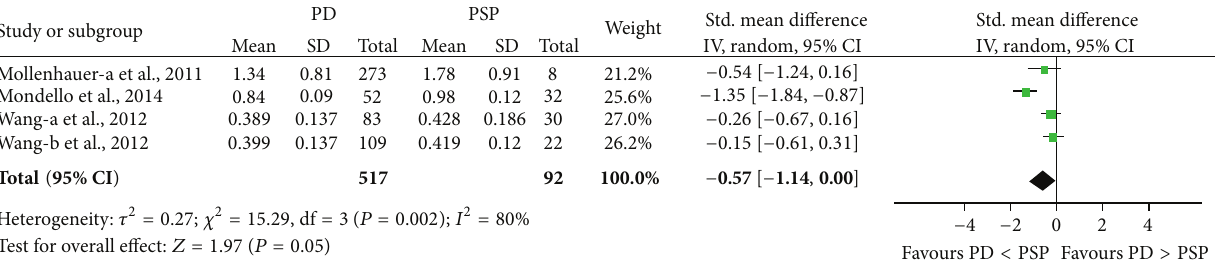
Figure 6: Forest plot of CSF 𝛼 -syn levels in PD compared to PSP.